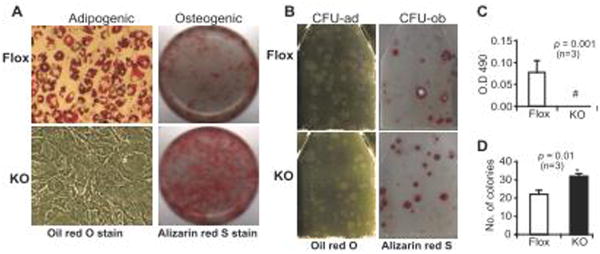
Adipogenic and osteogenic differentiation assays(A) BMSCs were subjected to standard adipocyte or osteoblast differentiation program. Cells were either stained with Oil red O for detection of adipocytes 9 days after induction (A, left panel), or stained with Alizarin red S for detection of mineralized bone nodules 21 days after induction (A, right panel). (B) Assays for the number of colony forming units (CFUs). Equal numbers of bone marrow cells (5×106 cells/25cm2 flask) from cKO and double-floxed mice were cultured in adipogenic or osteogenic induction media and stained with Oil Red O at day 11 for CFU-ad or with Alizarin red S at day 21 for CFU-ob. Colonies (>50 cells in size) were counted visually. These experiments were repeated two times in triplicates. Only one representative flask is shown for each group. (C, D) Quantitative results of B.